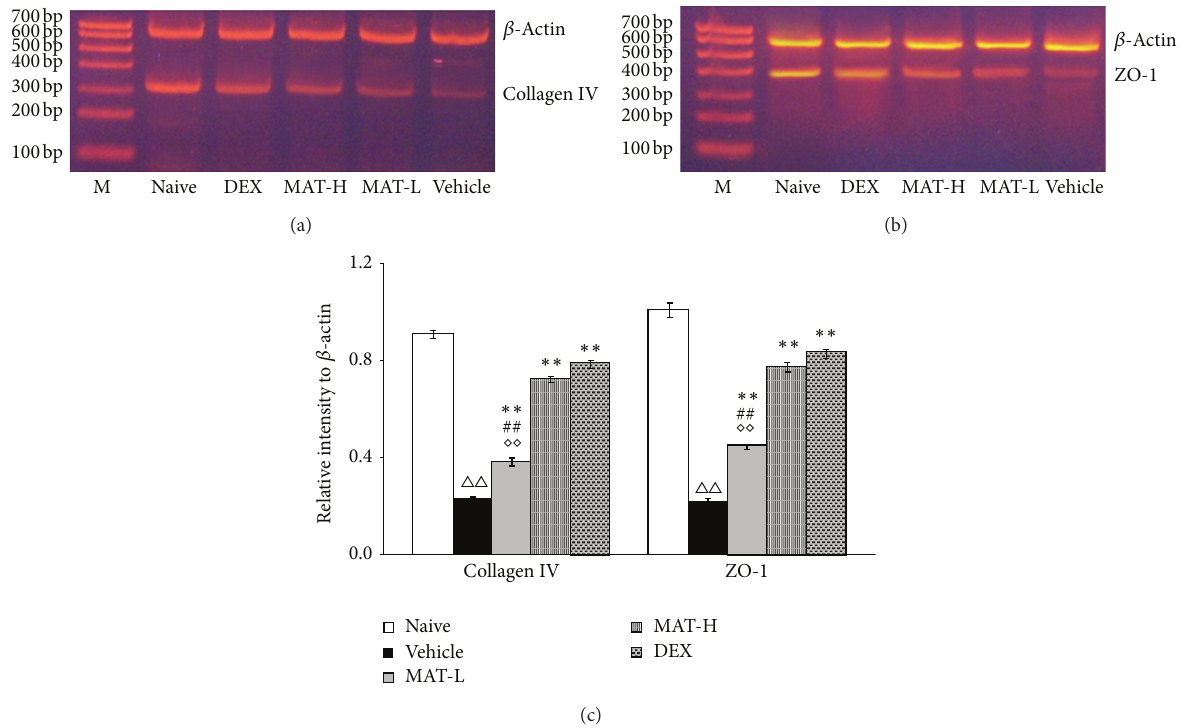
Figure 4: Collagen IV and ZO-1 mRNA expression. Spinal cords were harvested from treated and untreated EAE rats at day 17 p.i.; mRNA expression of collagen IV (a) and ZO-1 (b) was determined by RT-PCR, and an example of bands is shown. (c) Quantitative analysis. Results are expressed as mean ± SD ( 𝑛 = 8 each group). △△ 𝑃 < 0.01 , compared to naive group; ∗∗ 𝑃 < 0.01 , compared to vehicle group; ## 𝑃 < 0.01 , compared to DEX group; ◊◊ 𝑃 < 0.01 , comparison between MAT-L and MAT-H groups.